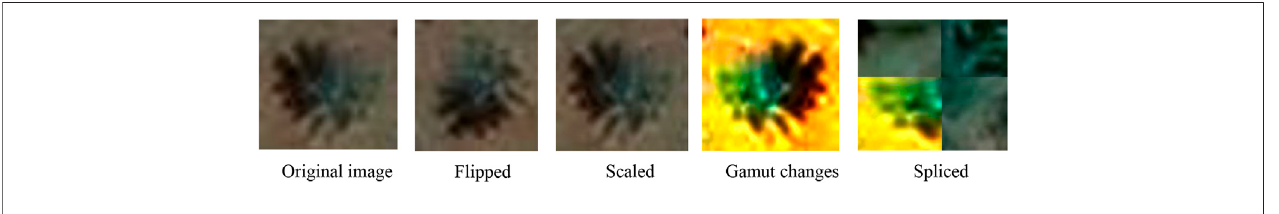
FIGURE 1 | Image of data enhancement.